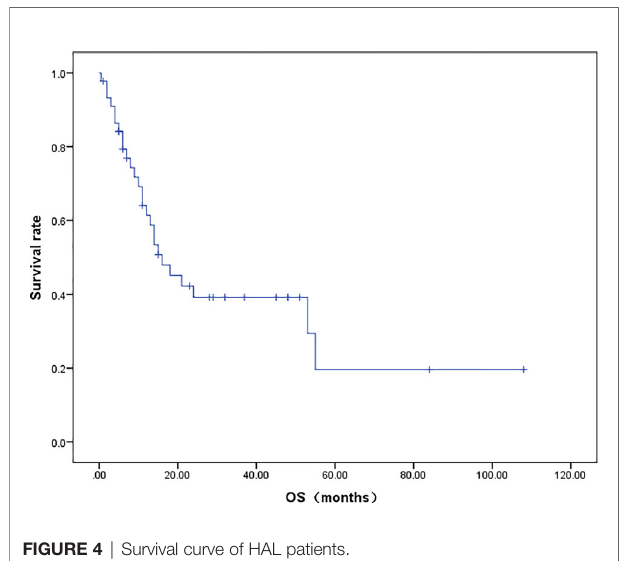
FIGURE 4 | Survival curve of HAL